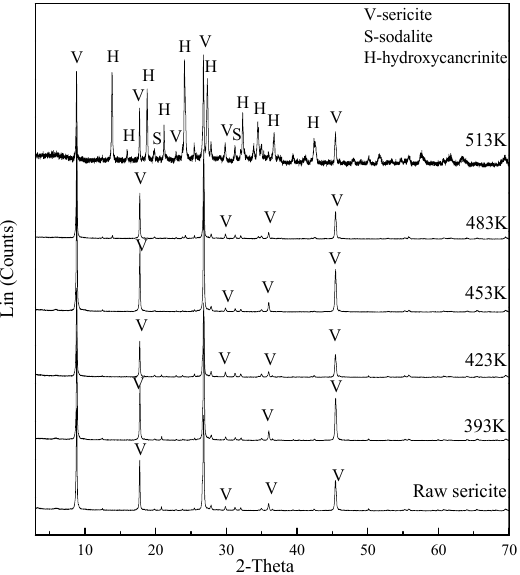
Figure 3. XRD analysis of alkali-leached residue treated at different alkali leaching temperatures.